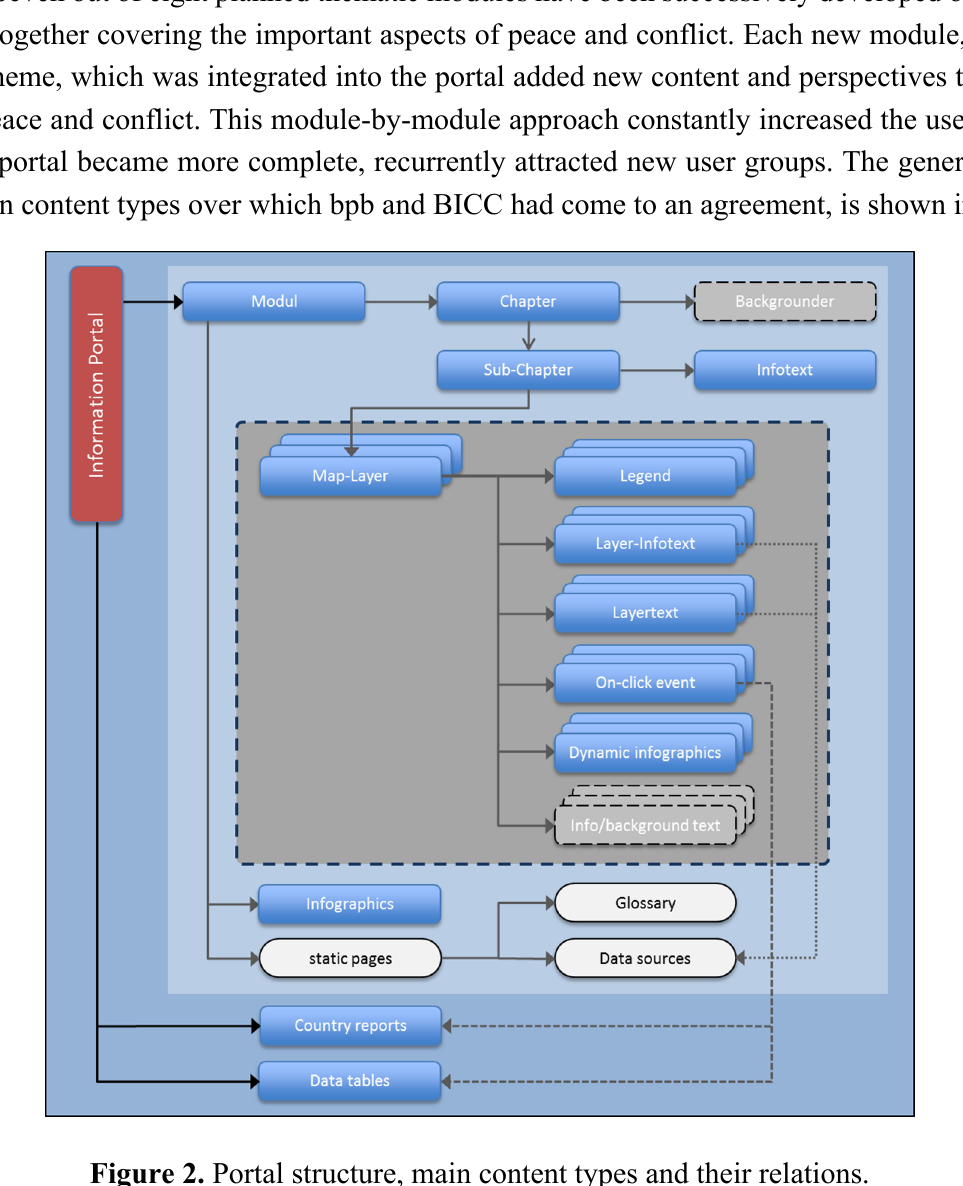
Figure 2. Portal structure, main content types and their